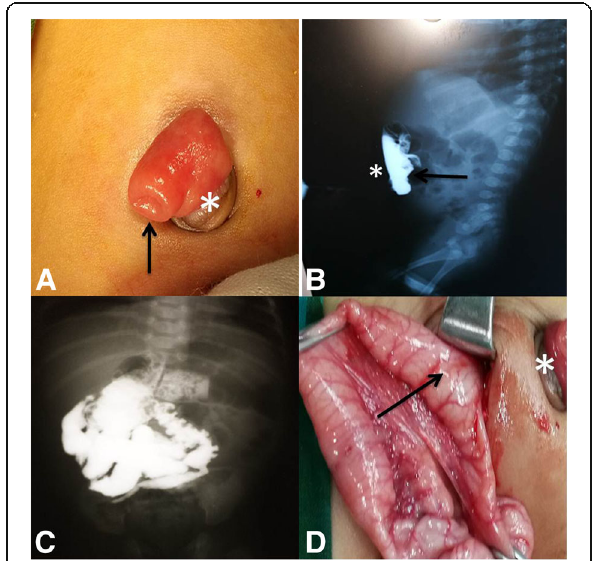
Fig. 7 An infant with vitello-intestinal fistula. a A photo showing the fistulous opening (arrow) at the umbilicus (*). b An initial fistulogram demonstrating the patent vitello-intestinal duct (arrow) behind the umbilicus (*). c The contrast image illustrates the opcified small intestinal loops distal to the patent vitello-intestinal duct. d Surgical image showing the site of the vitello-intestinal duct close to the umbilicus (*)